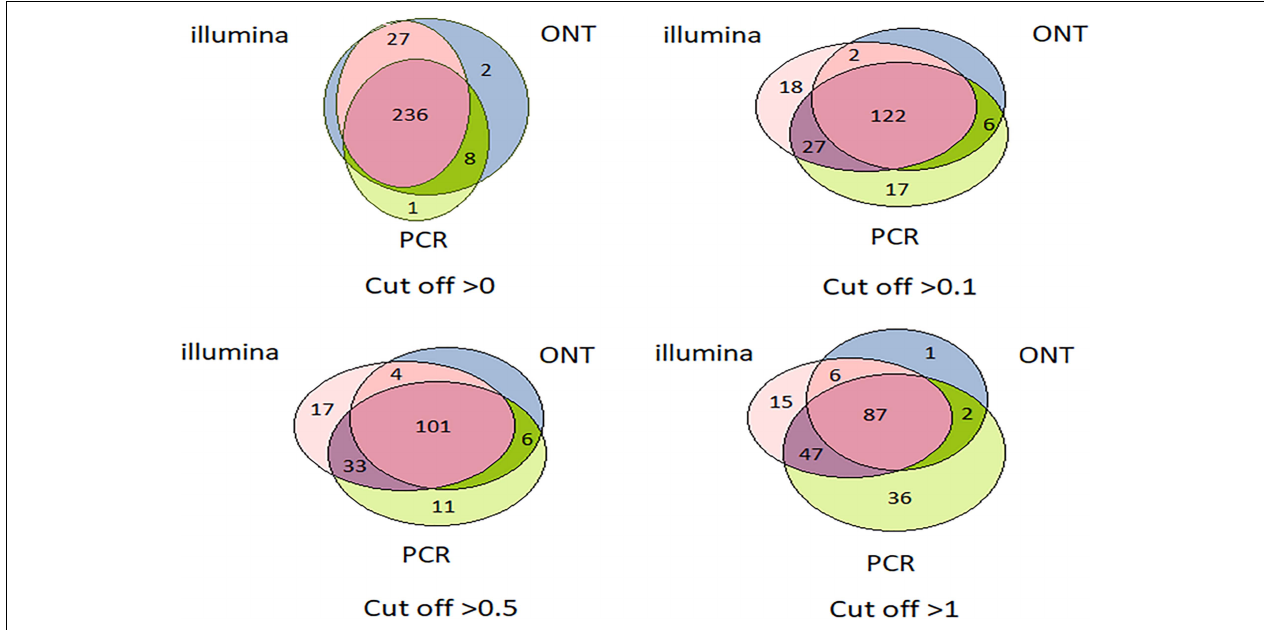
FIGURE 3 | Venn diagrams showing the detection of HepG2 cell line transcripts by the Illumina, ONT, and qPCR platforms depending on the selected cutoff level.